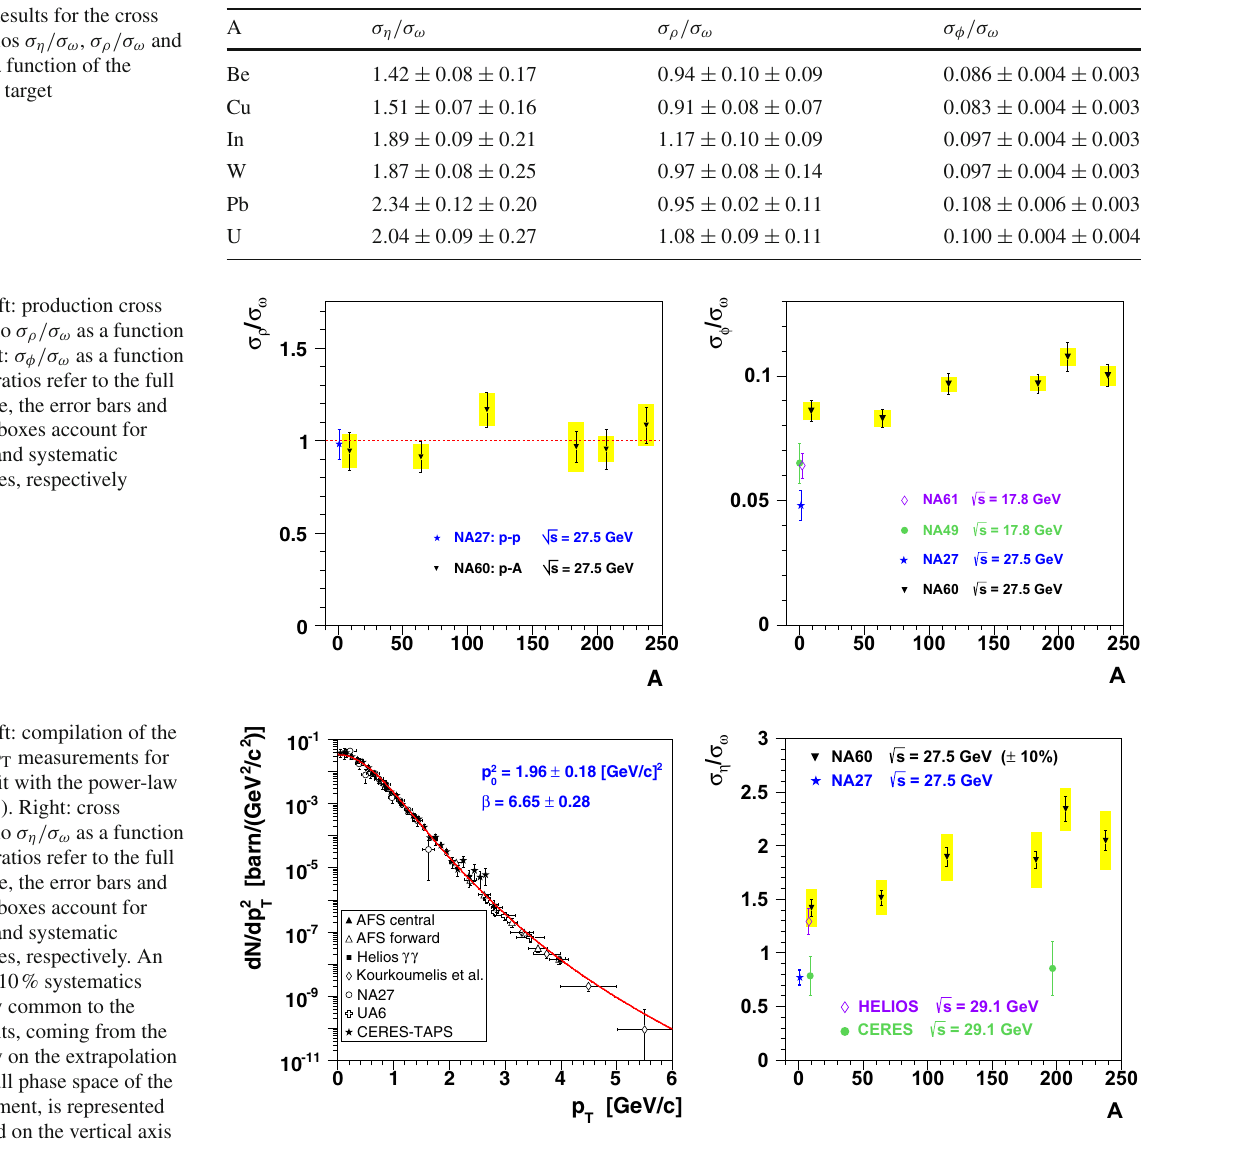
Table 3 Results for the cross section ratios σ η /σ ω , σ ρ /σ ω and σ φ /σ ω as a function of the production target